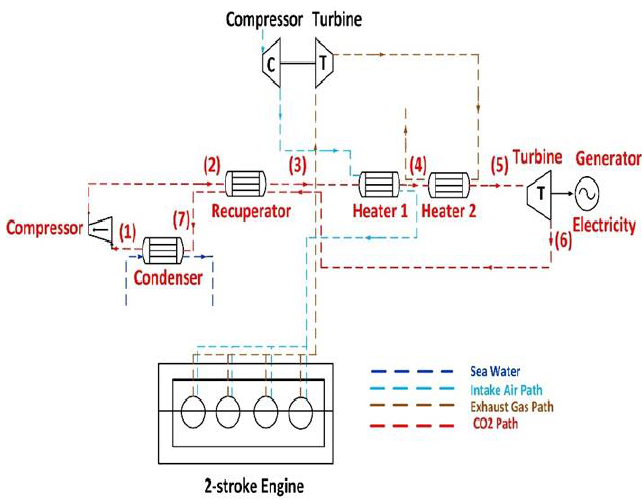
Figure 2. Schematic of a simple supercritical CO 2 bottoming cycle.